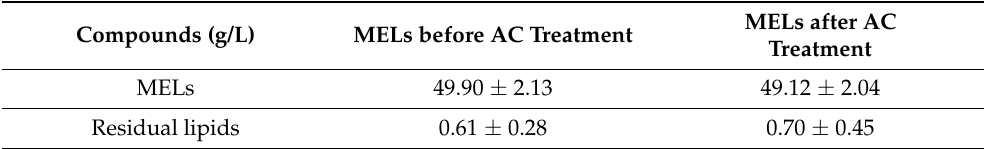
Table 6. Analysis of crude MELs composition before and after treatment with AC. MELs used were produced using AC-treated